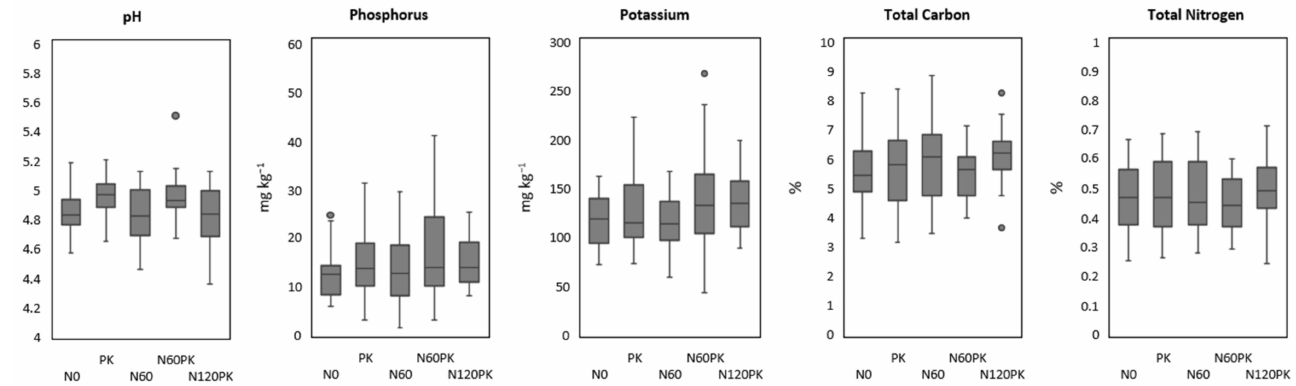
Figure A1. Soil chemical characteristics of fertilization treatments during the study period (soil sampling in 2010–2015, 2017). All variables did not significantly differ between treatments according to the generalized linear mixed model